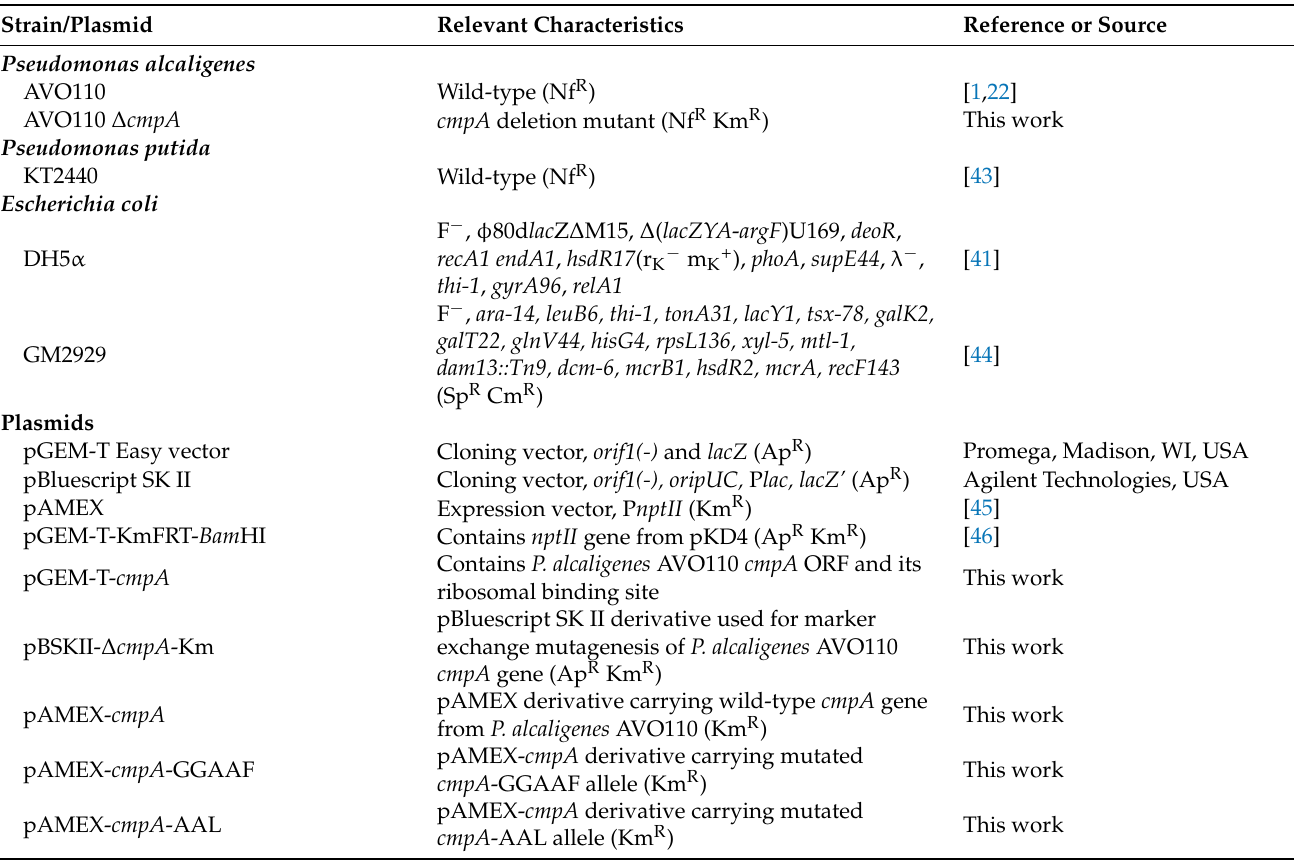
Table 1. Bacterial strains and plasmids used in this